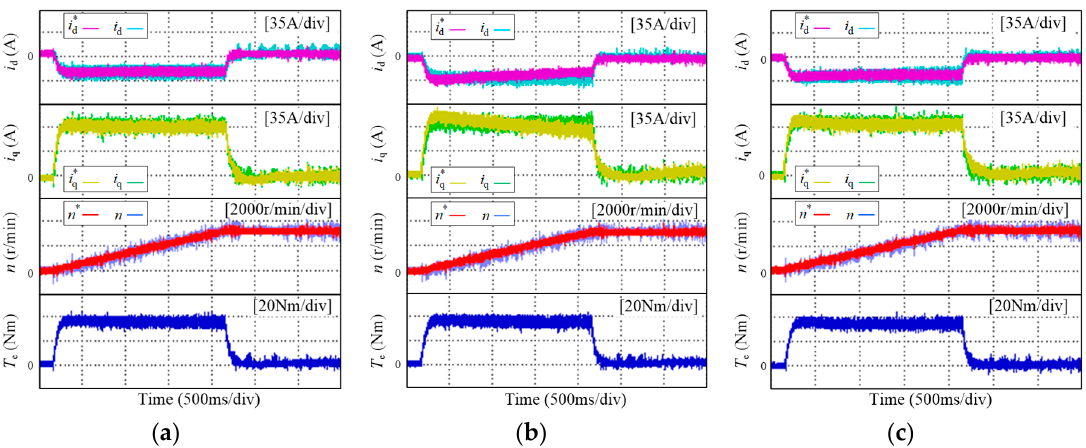
Figure 9. Tracking performance in the constant torque region: ( a ) The traditional control strategy-based PI controller; ( b ) The traditional UDE-based control without parameter tuning; ( c ) The improved UDE-based control with parameter tuning.